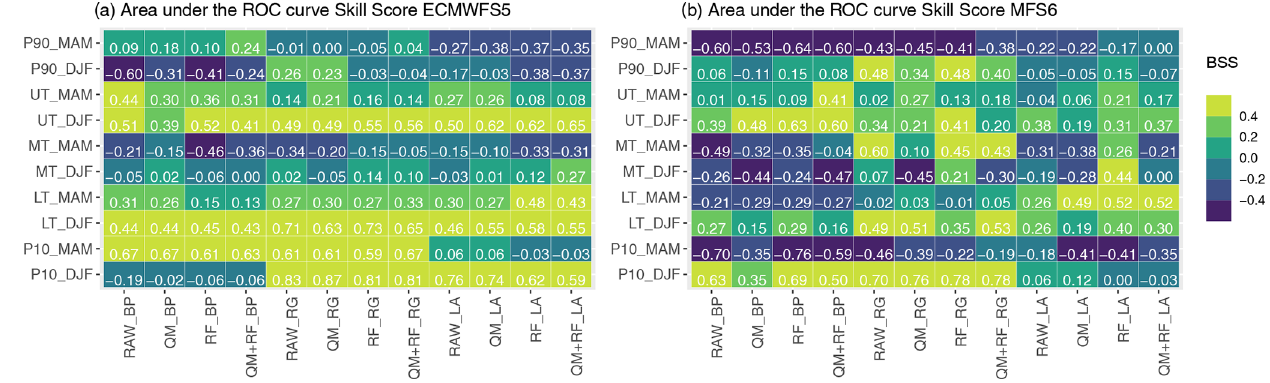
Figure 10. AUCSS of the detrended seasonal (DJF, MAM) snow depth forecasts in the lower (LT), middle (MT), upper (UT) tercile, as well as in the lower (P10) and upper (P90) extreme of the distribution, with respect to the climatological forecasts, using observations at the three stations as a reference, for (a) ECMWFS5 and (b) MFS6 systems. Positive and negative AUCSSs are highlighted in shades of green and blue, respectively.